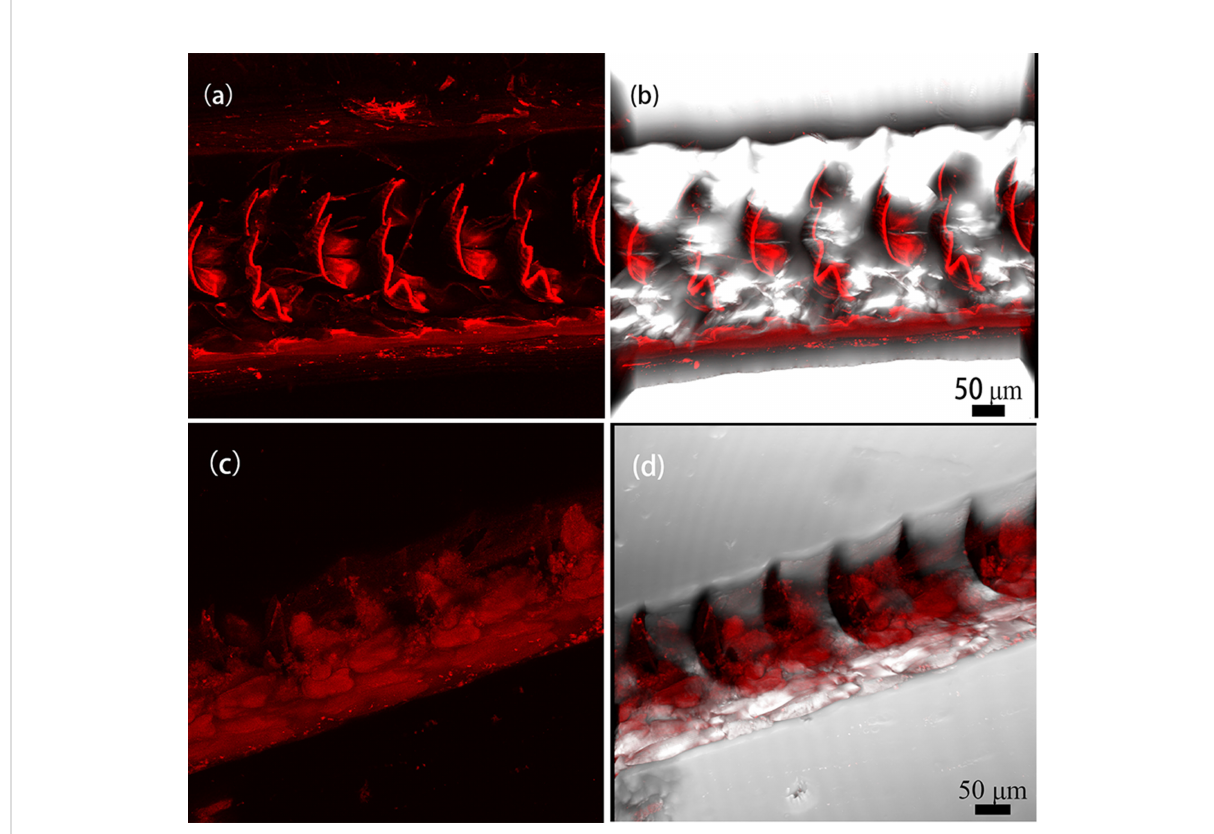
FIGURE 6 Binding of CtCBP-1-cy5 in the radulae of limpets. (A) binding of CtCBP-1 on radulae, (B) CtCBP-1, a merged image, (C) binding of MBP on radulae, (D) MBP, a merged